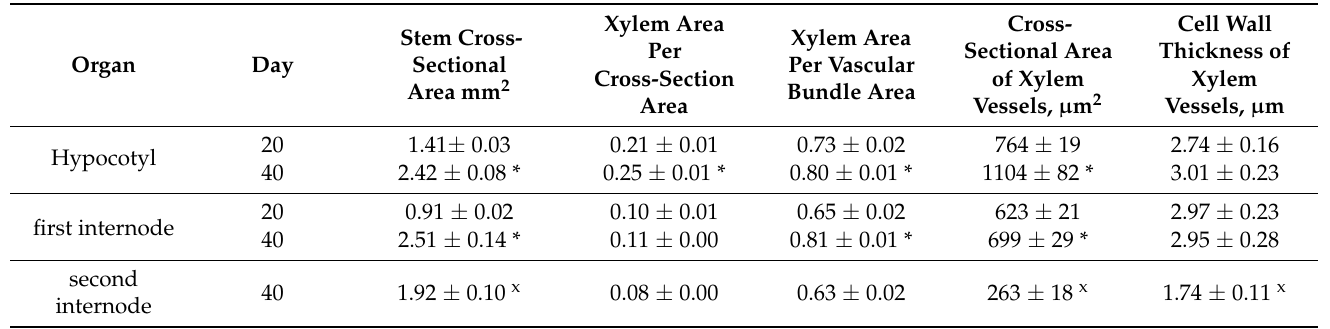
Table 1. Anatomical and morphological parameters of the zinnia axial organs on the 20th and 40th day of